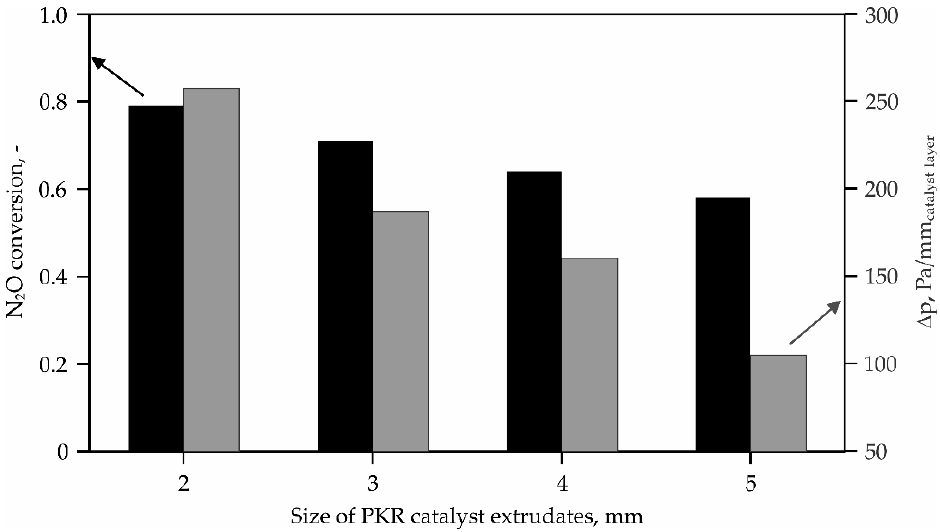
Figure 1. The dependence of N 2 O conversion and pressure drop across the PKR catalyst layer (Δ p ) on the size of the catalyst extrudes forming the layer. Test parameters: T NG = 890 °C, p = 5 bar, V NG = 58 Nm 3 /h.